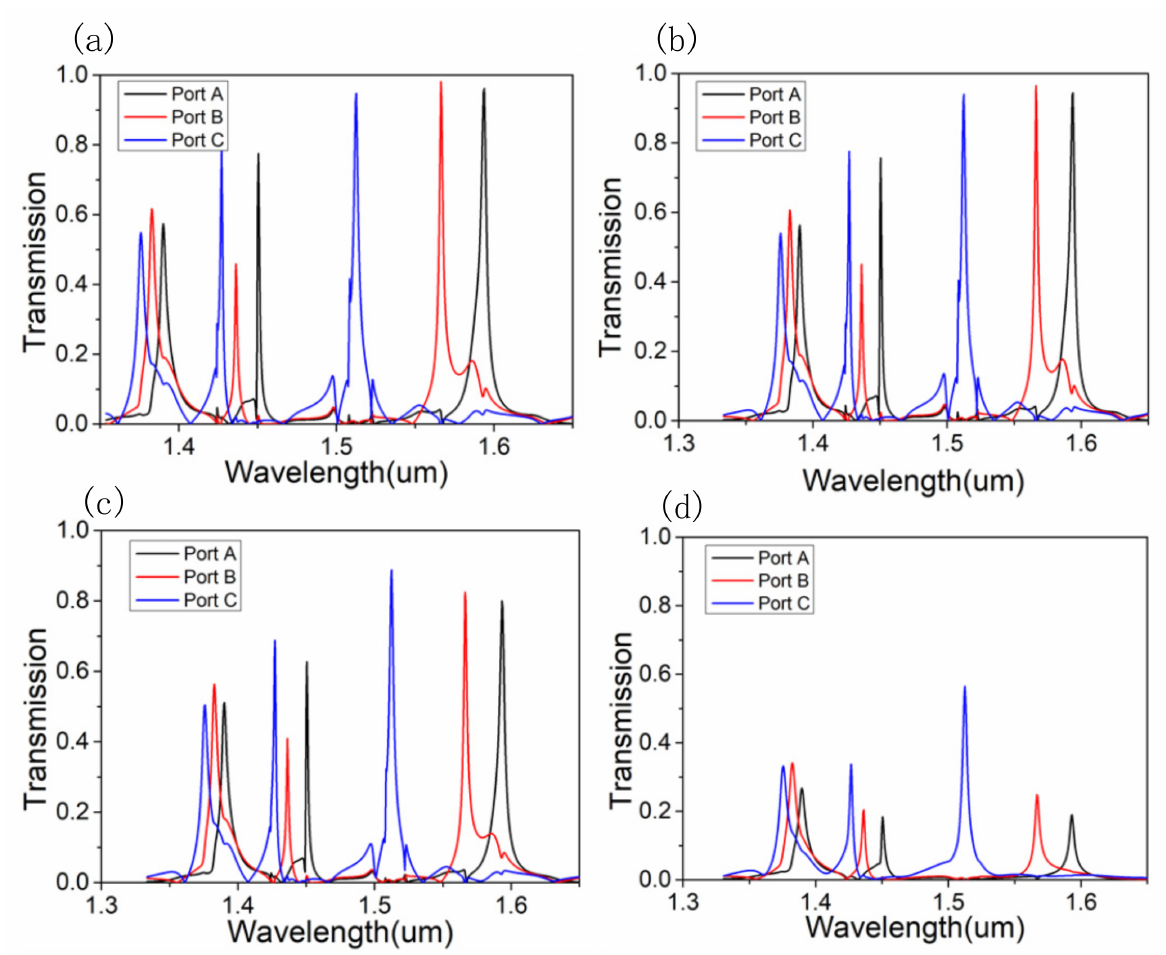
Figure 7. Transmission spectrum of the photonic crystal filter reduced from the top, which reduces ( a ) one layer, ( b ) two layers, ( c ) three layers, and ( d ) four layers. According to the transmission spectrum, the transmittance of the three channels is compared, as shown in Figure 8. It should be explained here that only points in the dot plot have the actual meaning of representing the data, and the lines are only for the convenience of distinguishing different filters. In the figure, U0 represents the original value of the filter with no reduction at the top, U1 represents the value of the filter with one layer reduction at the top, U2, U3, and so on.